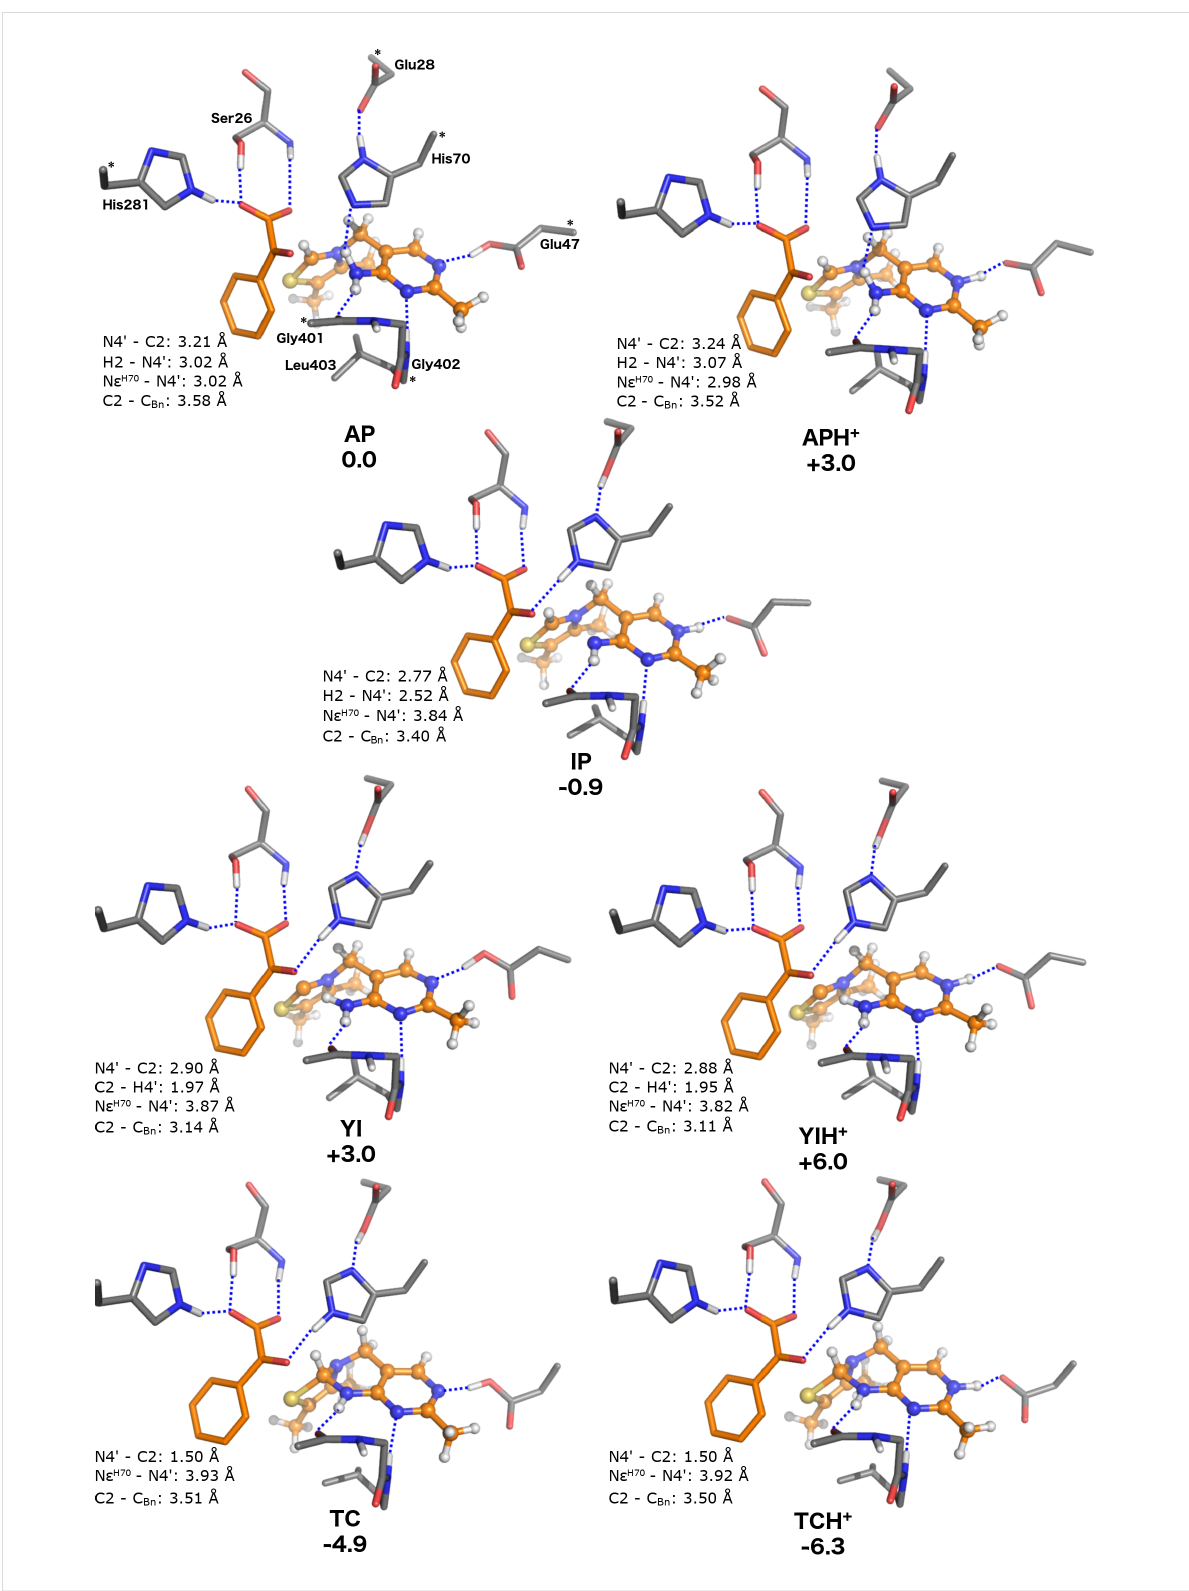
Figure 5: Optimized structures of the ThDP states in the BFDC active site containing the substrate, benzoylformate (model D ). Relative energies are indicated in